Question: What kind of plot is shown here?
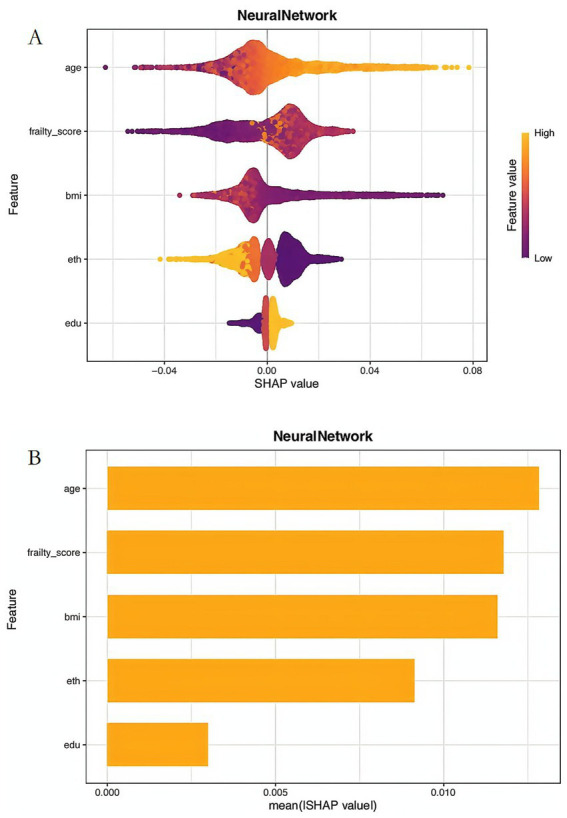
Answer: bar